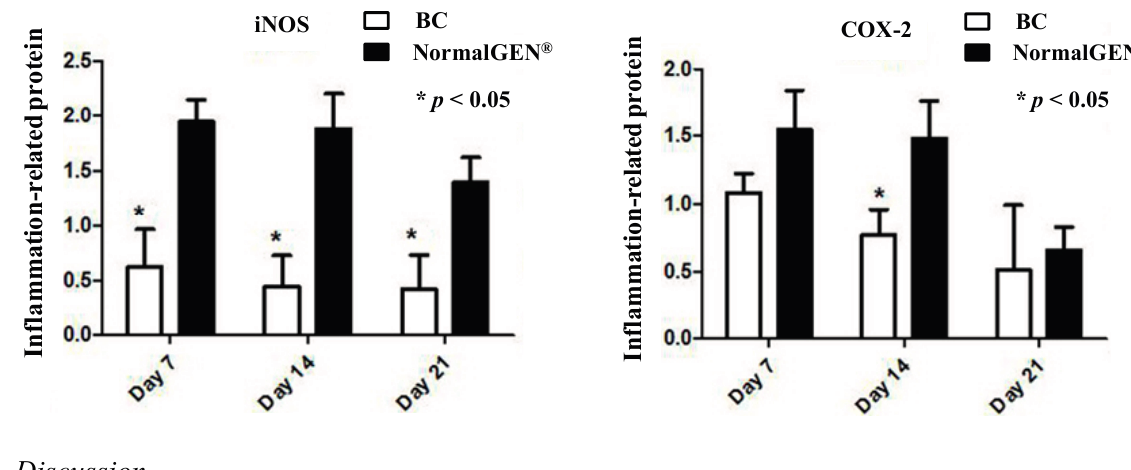
Figure 6. Western blot analysis of iNOS and COX-2 expression. Dural defects of rabbits were repaired by BC and NormalGEN ® on each side. After 7, 14 and 21 days, western blot analysis was performed for protein expression normalized by GAPDH. Data are expressed as mean ± SD. * p < 0.05 vs . control ( n =